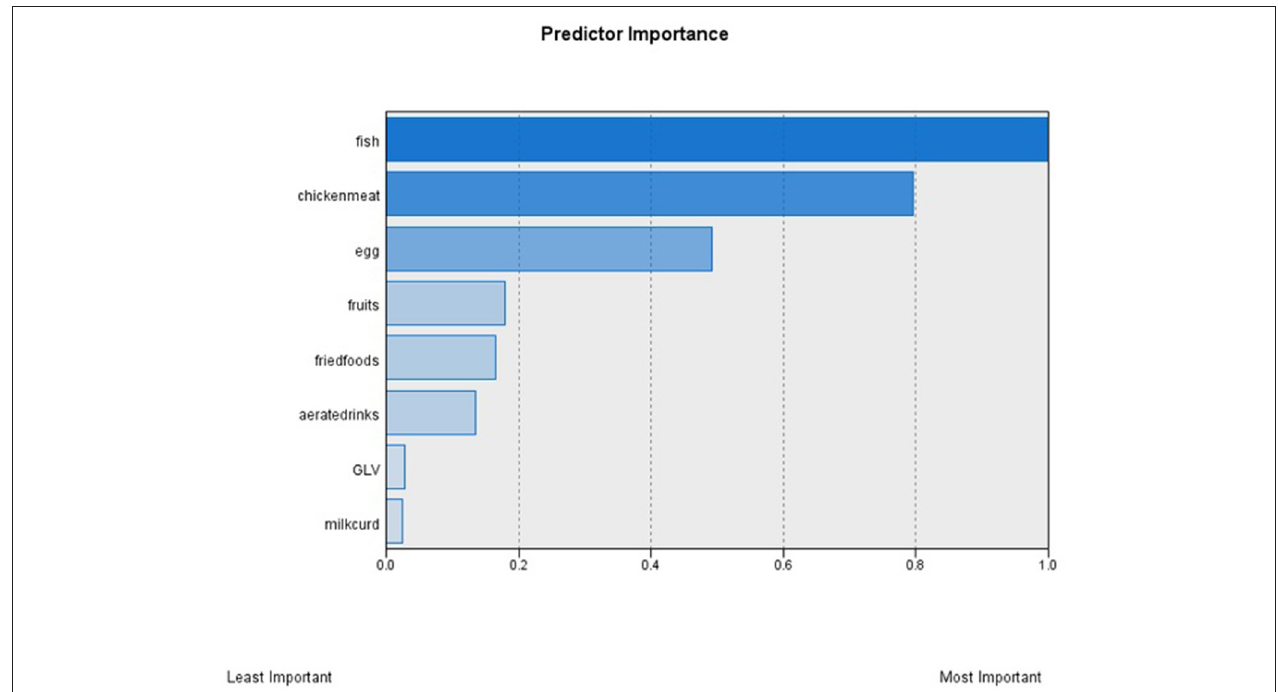
FIGURE 1 | Predictor importance of the selected food groups ( n = 8). GLV, Green, including leafy vegetables. Contribution of each food item to the clustering solution as reported from the Two-Step cluster analysis. This shows the index of relative importance of each food item as identified by the Two-Step cluster analysis. Fish and chicken/meat had high predictor importance, meaning that they are responsible for the wide difference between the clusters. On the contrary. Green leafy vegetables (GLV) and milk/curd had lowest predictor importance. So, they are important in predicting a